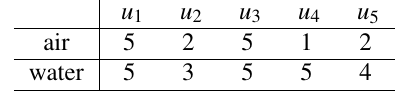
Table 2. Evaluating data based on soil and